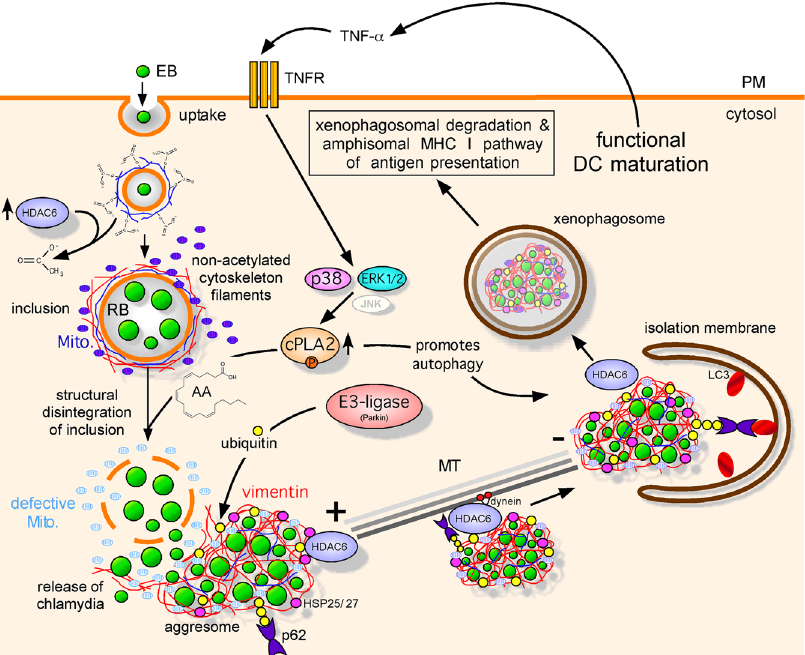
Figure 9. Model of mito-xenophagic degradation of bacterial structures in chlamydia-infected DCs. Infected DCs destroy inclusions resulting in the cytosolic release of bacteria. HDAC6-mediated deacetylation of stable MTs promotes inclusion disruption and a structural collapse of the associated vimentin. This is accompanied by a TNF- α mediated induction/activation of cPLA2, which catalyses the synthesis of AA. AA triggers disintegration of the fragile inclusions by affecting the proper function of inclusion-associated mitochondria. Since mitochondrial energy supply is essential for normal development and integrity of inclusions, a metabolic switch in infected DCs from OXPHOS to aerobic glycolysis causes irreversible damage to the bacteria. Chlamydial remnants are associated with collapsed vimentin, HDAC6, Parkin, small heat shock proteins (e.g. HSP25/27) as well as Pink-1-positive mito-aggresomes. Ubiquitinated aggresomal structures recruit p62, which binds to phagophore-conjugated LC3. Finally, xenophagosomes fuse with endo/lysosomal vacuoles. In parallel to the destruction of chlamydia, bacterial antigens are generated by the amphisomal pathway and are loaded onto MHC I derived from endosomal recycling. MHC I molecules successfully loaded with antigen are presented on the cell surface to CD8 + T